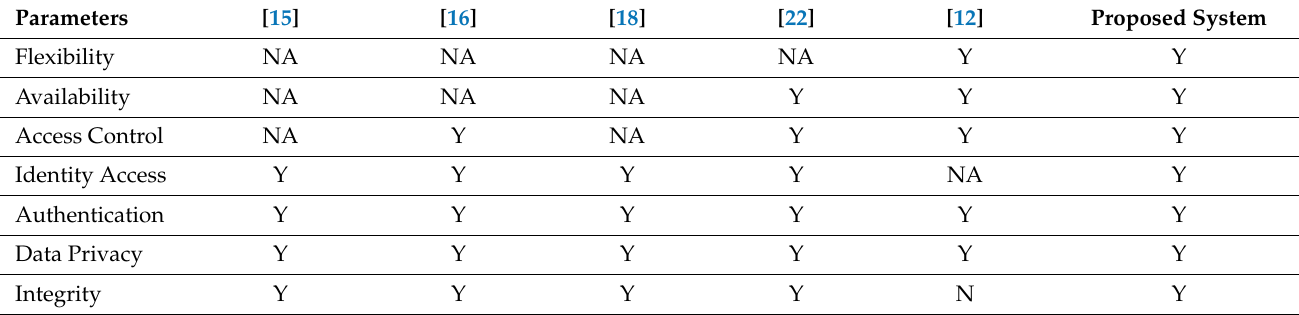
Table 2. Performance evaluation comparison with existing